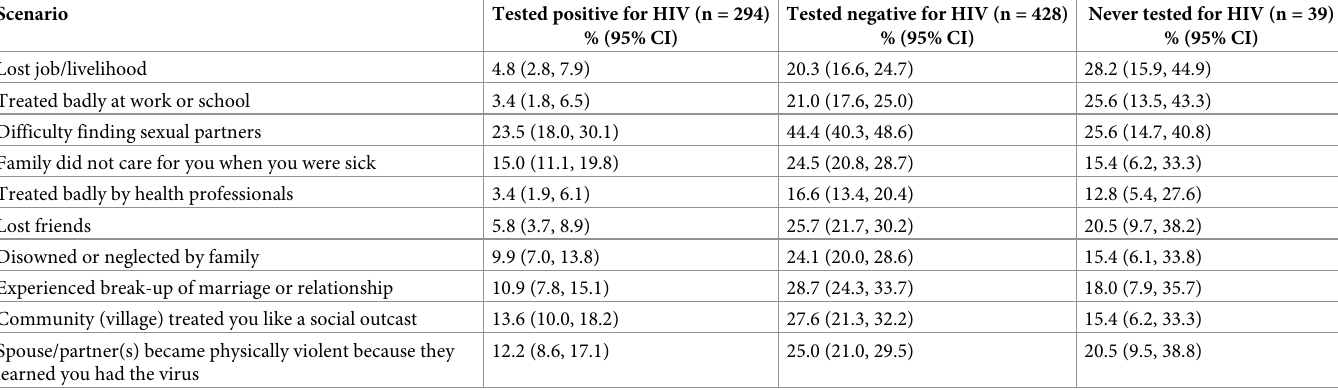
Table 2. HIV-related stigma among caregivers reporting to be living with HIV, reporting to be negative for HIV and never having been